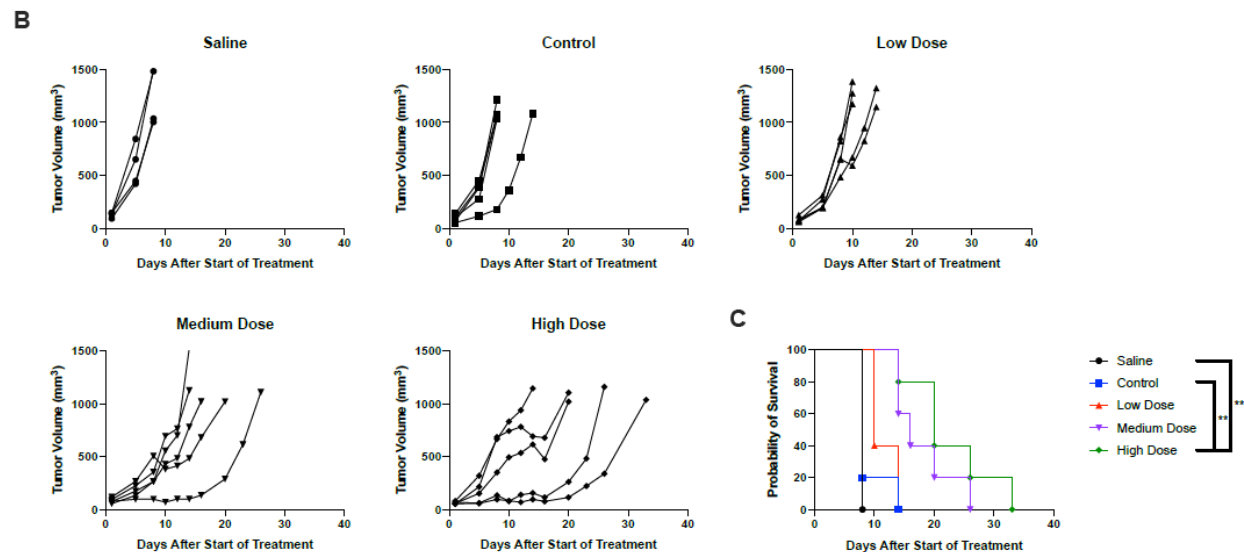
Figure 5. Two administrations of the highest dose RT improved survival outcomes. ( A ) C57/Bl6 mice bearing subcutaneous E0771 tumors on the left flank were treated with PBS, control (non-radioactive compound), low dose (0.74 MBq), medium dose (2.78 MBq), or high dose (4.44 MBq) on days 1 and 6. *Created using BioRender.com. ( B ) Tumor volumes were measured every 2–3 days from the start of treatment until mice reached endpoint. Each line represents an individual mouse within the group. ( C ) Kaplan–Meier survival curves of each group. ** p < 0.01.